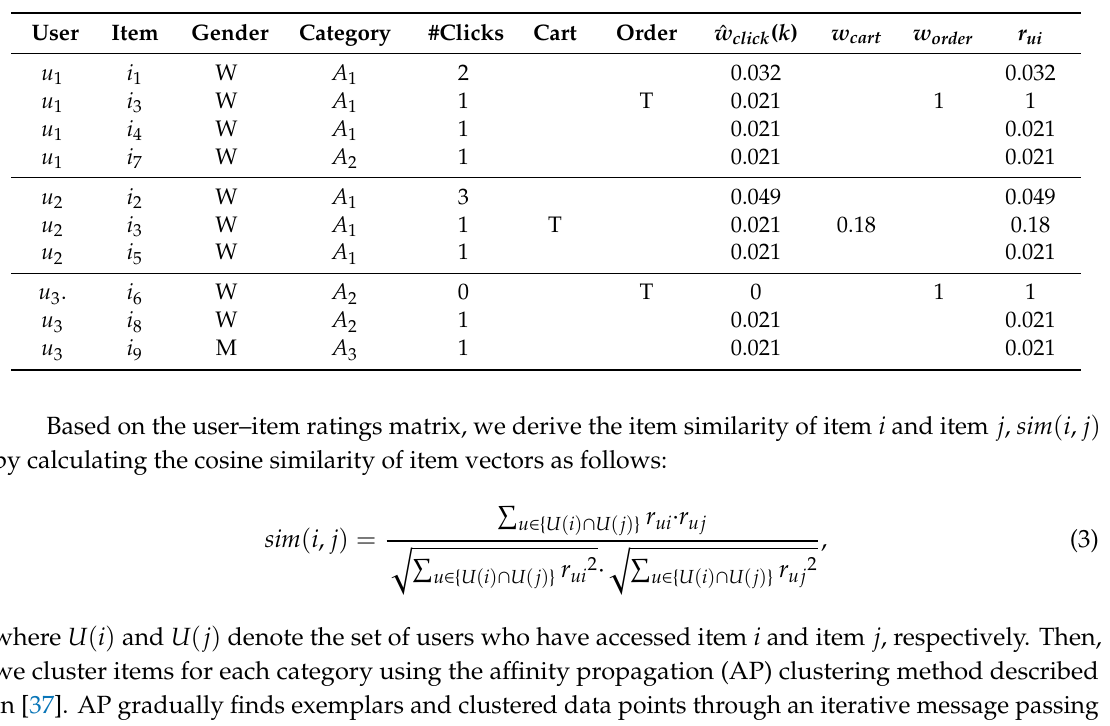
Table 2. Generation of ratings by using user